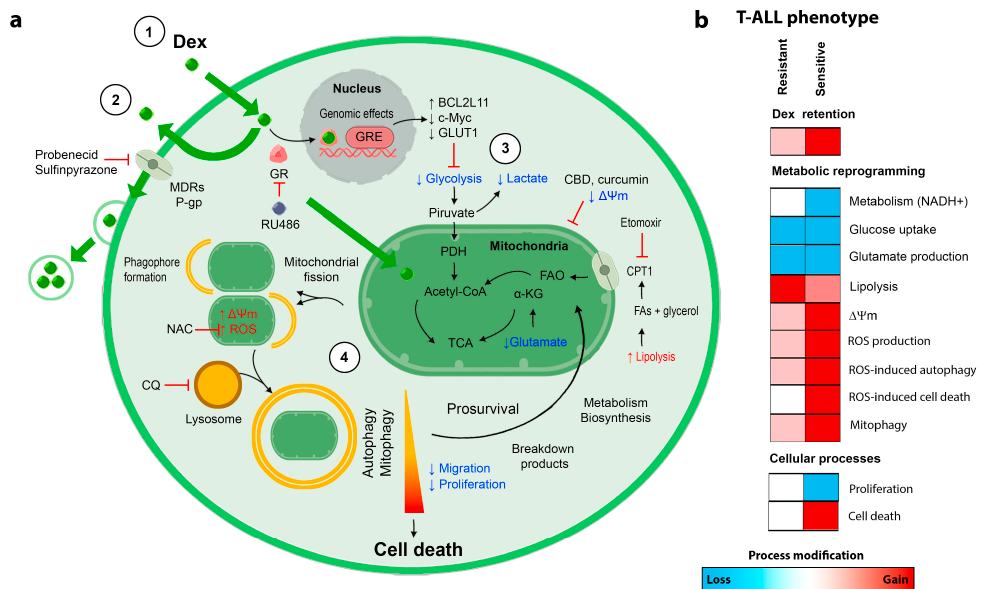
Figure 7. ( a ) Summary of Dex-induced changes in T-ALL cells. ( 1 ) Dex was rapidly taken up and showed better retention in GC-sensitive CCRF-CEM cells. In addition to well-known canonical mechanisms, mediated by GR, nuclear translocation, and changes in gene expression, Dex prefer- entially targeted mitochondria in T-ALL. ( 2 ) T-ALL cells actively extruded Dex. Inhibition of MDRs and P-gp-mediated active extrusion mechanisms by probenecid and sulfinpyrazone induced an al- ternative pathway for Dex extrusion via the release of Dex-loaded large extracellular vesicles. ( 3 ) Dex decreased glucose uptake, glycolysis, and glutaminolysis. As a compensatory mechanism, lipid metabolism was increased; lipolysis was up-regulated and T-ALL cells became sensitive to inhibi- tors of CPT1 (etomoxir), which imports FAs into mitochondria. Dex acted synergistically with com- pounds, suppressing the mitochondrial function (CBD or curcumin, causing mitochondrial Ca 2+ overload and collapsing the ΔΨ m). ( 4 ) Changes in mitochondrial metabolism, induced by Dex, fa- vored mitochondrial fission. Mitochondria in Dex-treated T-ALL cells exhibited an increased ener- gization and elevated ROS production. Increased ROS level stimulated autophagy/mitophagy. The degree of autophagy/mitophagy induction determined the cell fate. In CCRF-CEM cells, Dex-in- duced autophagy suppressed the proliferation, which could be reverted by ROS scavenging with NAC. Excessive autophagy could eventually lead to cell death. A moderate increase in autophagy in Jurkat cells favored a pro-survival scenario, likely via recycling of autophagy products and their usage for biosynthesis and energy production. Lastly, the stoppage of autophagy by CQ caused a dramatic increase in Dex cytotoxicity in both T-ALL cell lines. ( b ) Differences in the responses of GC-resistant and GC-sensitive cell lines to Dex. Color coding: blue means a decrease in the process rate or parameter value, white means no significant change, and red means an upregulation. Ab- breviations: GR: glucocorticoid receptors; P-gp: p-glycoprotein; MDR: multidrug resistance pro- teins; GRE: glucocorticoid response elements; GLUT1: glucose transporter 1; PDH: pyruvate dehy- drogenase; FAs: free fatty acids; CPT1: carnitine palmitoyltransferase 1; FAO: fatty acid oxidation; α -KG: alpha ketoglutarate; TCA: tricarboxylic acid cycle; ΔΨ m: mitochondrial membrane potential; CQ: chloroquine; ROS: reactive oxygen species; CBD: cannabidiol; NAC: N-acetyl-cysteine.